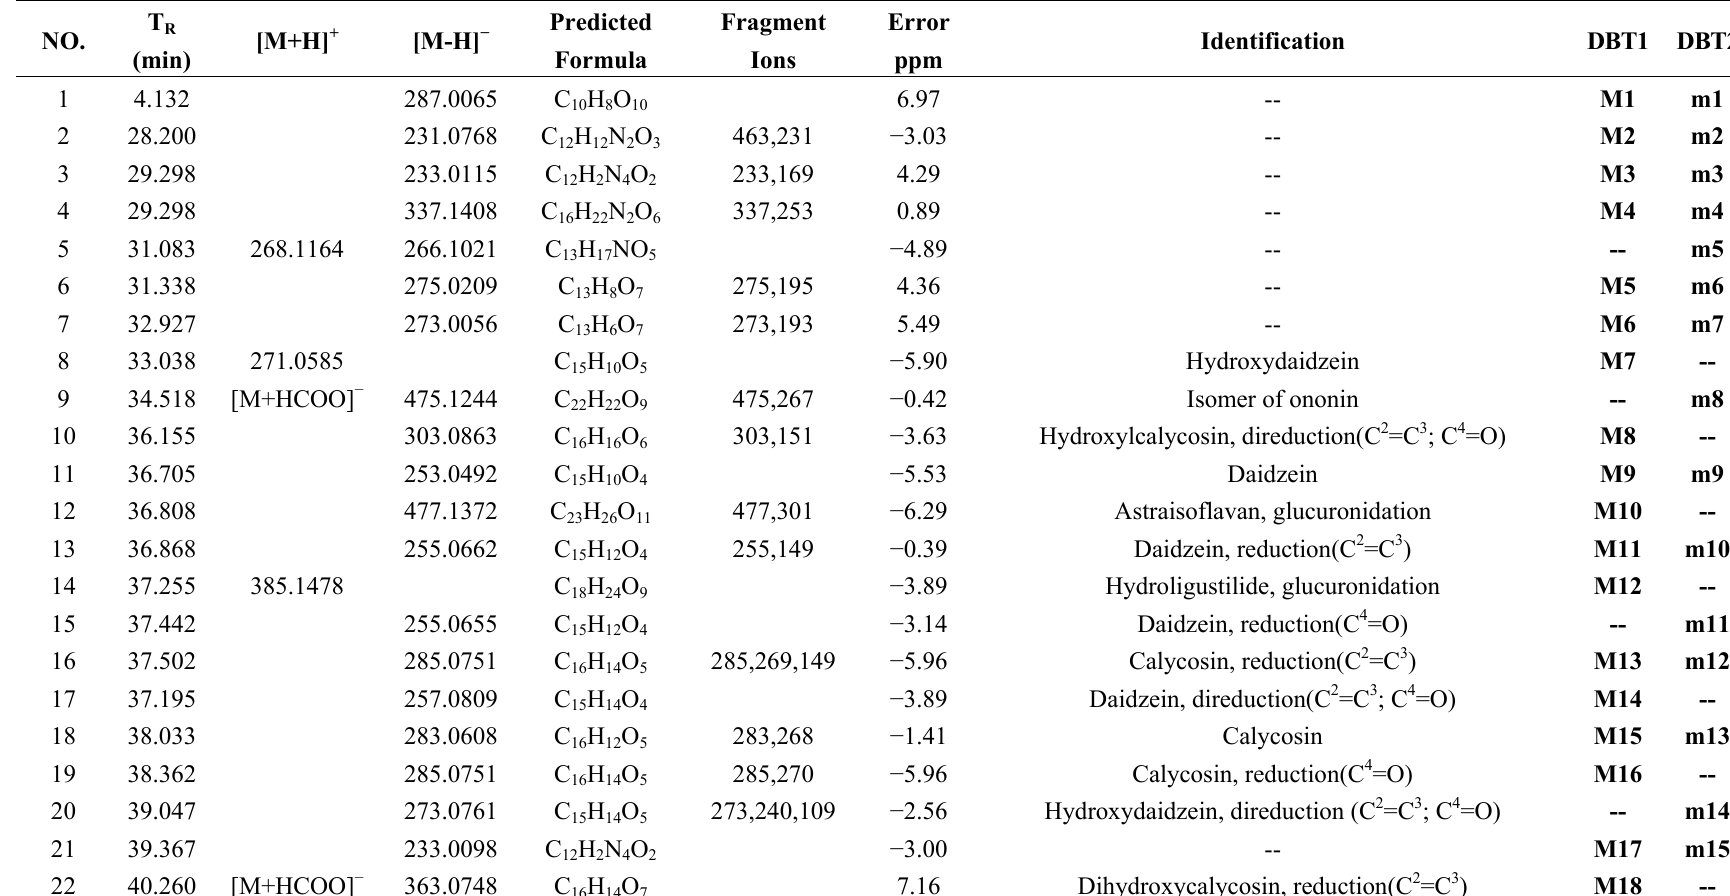
Table 4. The identified proposed metabolites from the urine samples of rats that had been administrated Danggui Buxue Tang1 and Danggui Buxue Tang